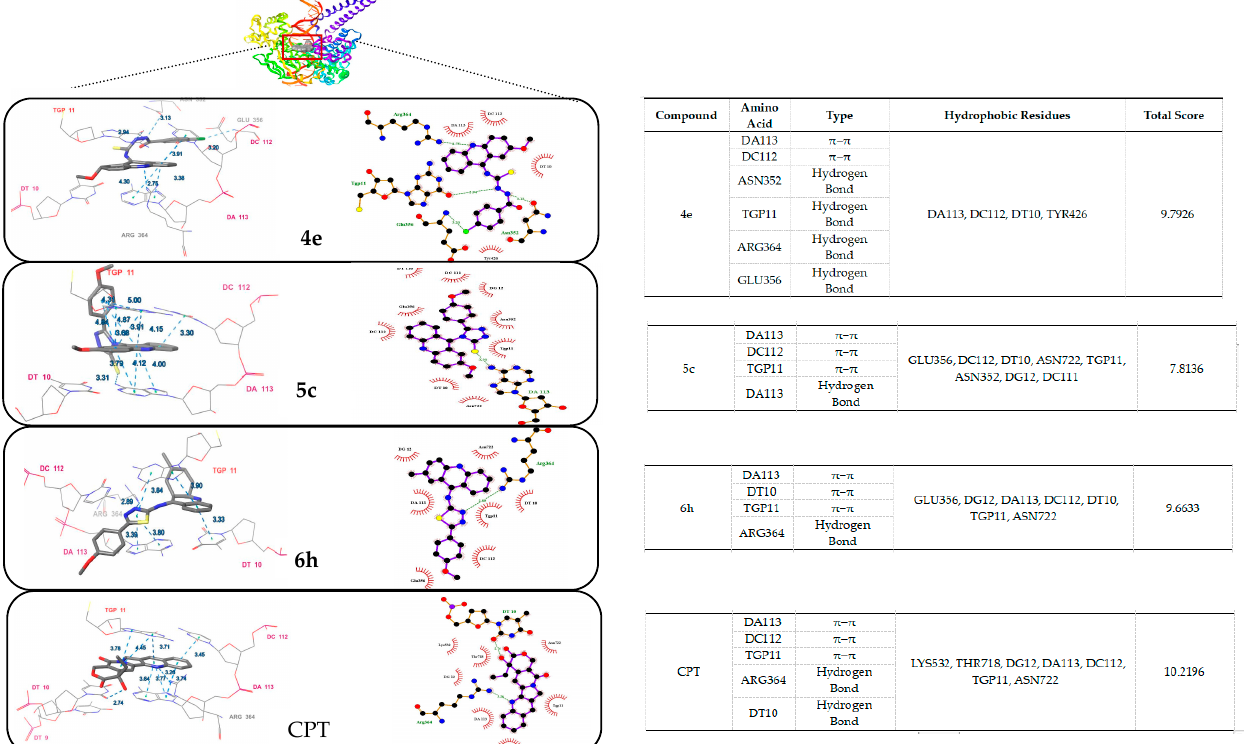
Figure 10. The best pose of the binding mode of compounds ( 4e , 5c , 6h and CPT ) with DNA Topo I complex (PDB:1T8I).